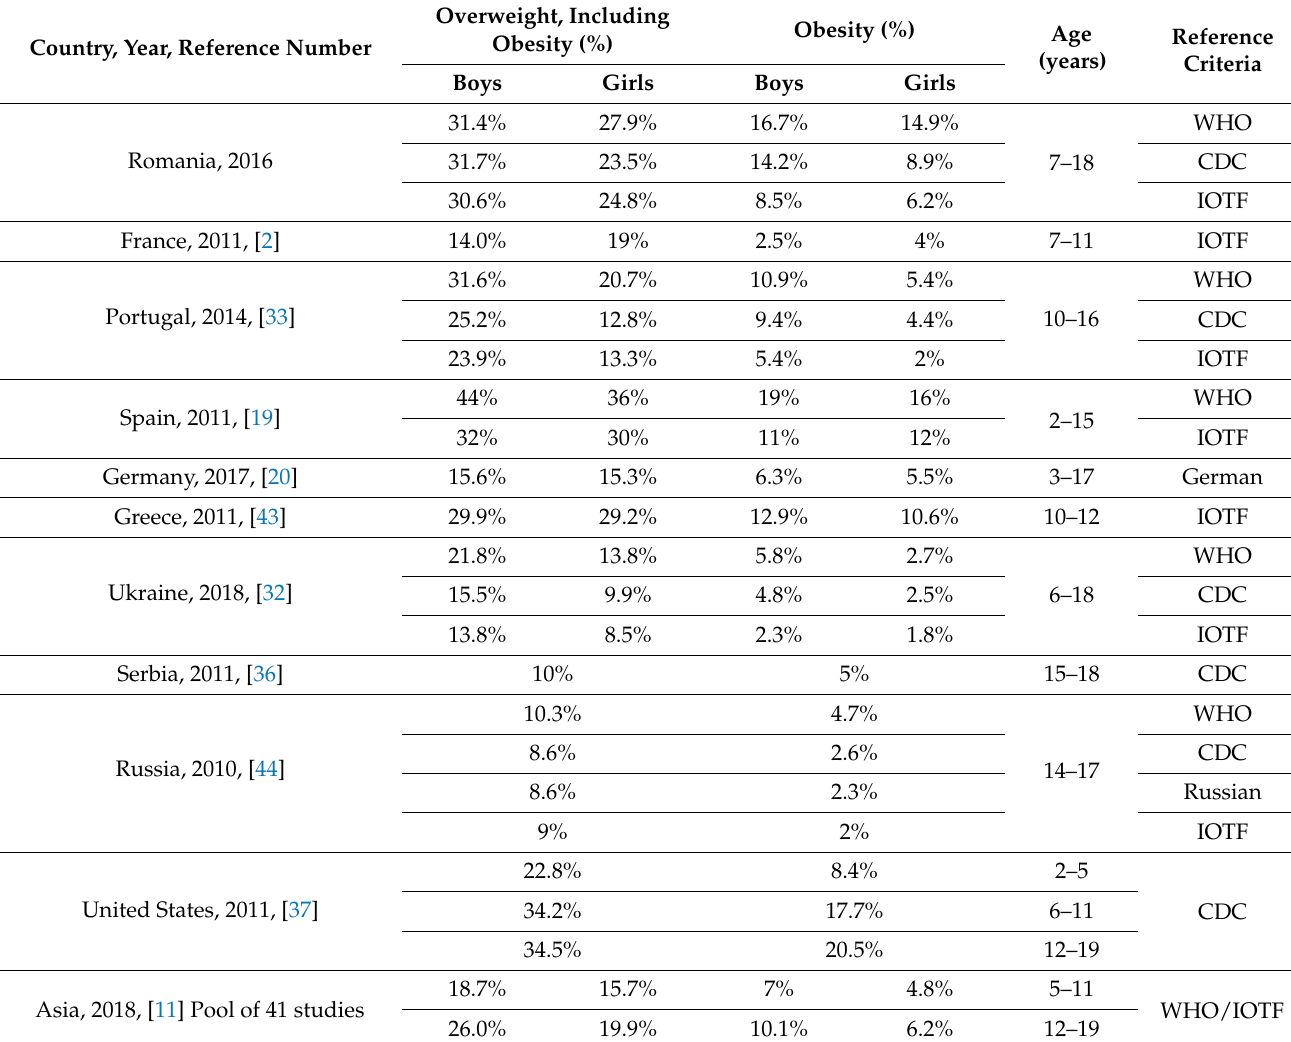
Table 11. Prevalence of overweight (including obesity) and obesity in children in different countries, based on various